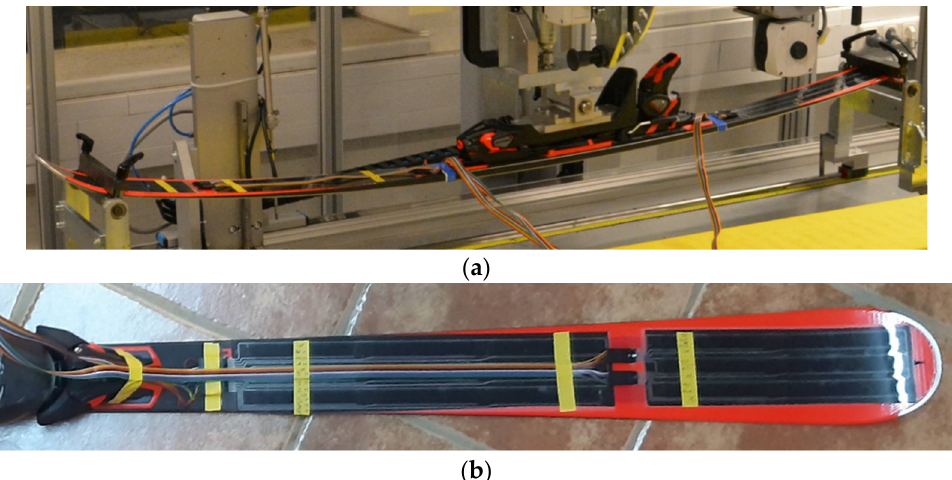
Figure 1. ( a ) Ski prototype with 24 single connected sensors. One foil element was implemented at the rear (nine sensors) and two foil elements at the front (fifteen sensors). ( b ) Detailed view of the sensors in the front ski segment. The sensors were laminated to the ski with a black high-perfor- mance adhesive tape (very temperature and UV